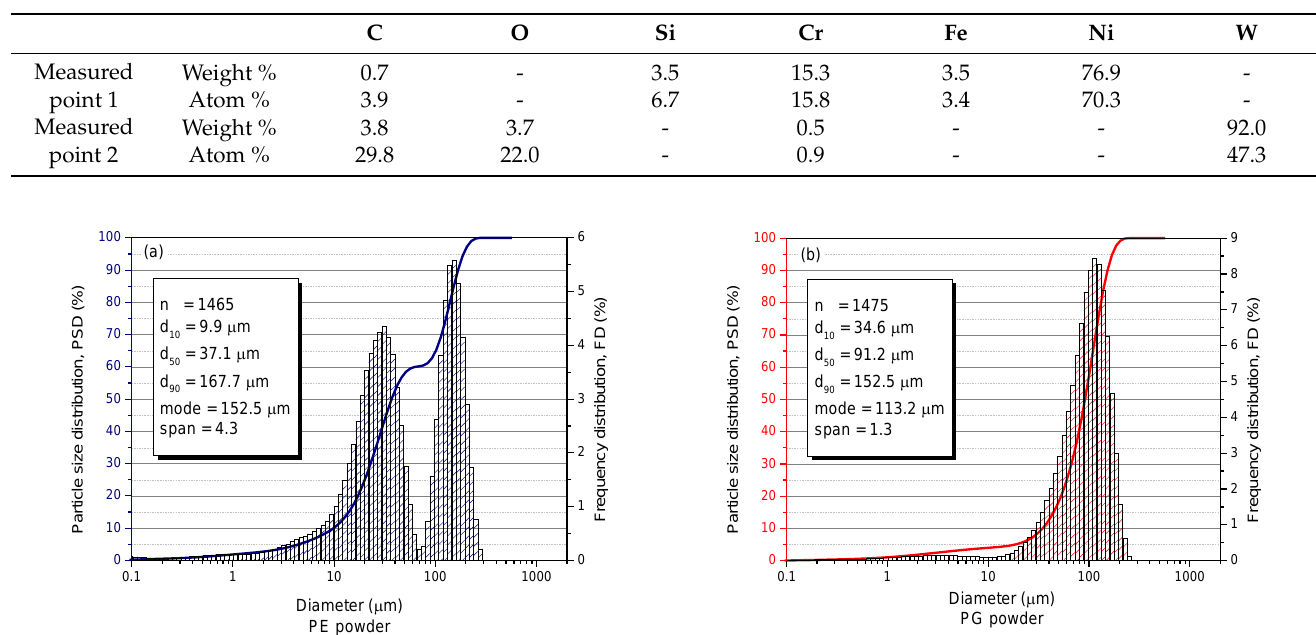
Figure 7. Particle size distribution (PSD) plots for the MMC powders ( a ) PE powder PSD plot with particle statistics ( b ) PG powder PSD plot with particle statistics.